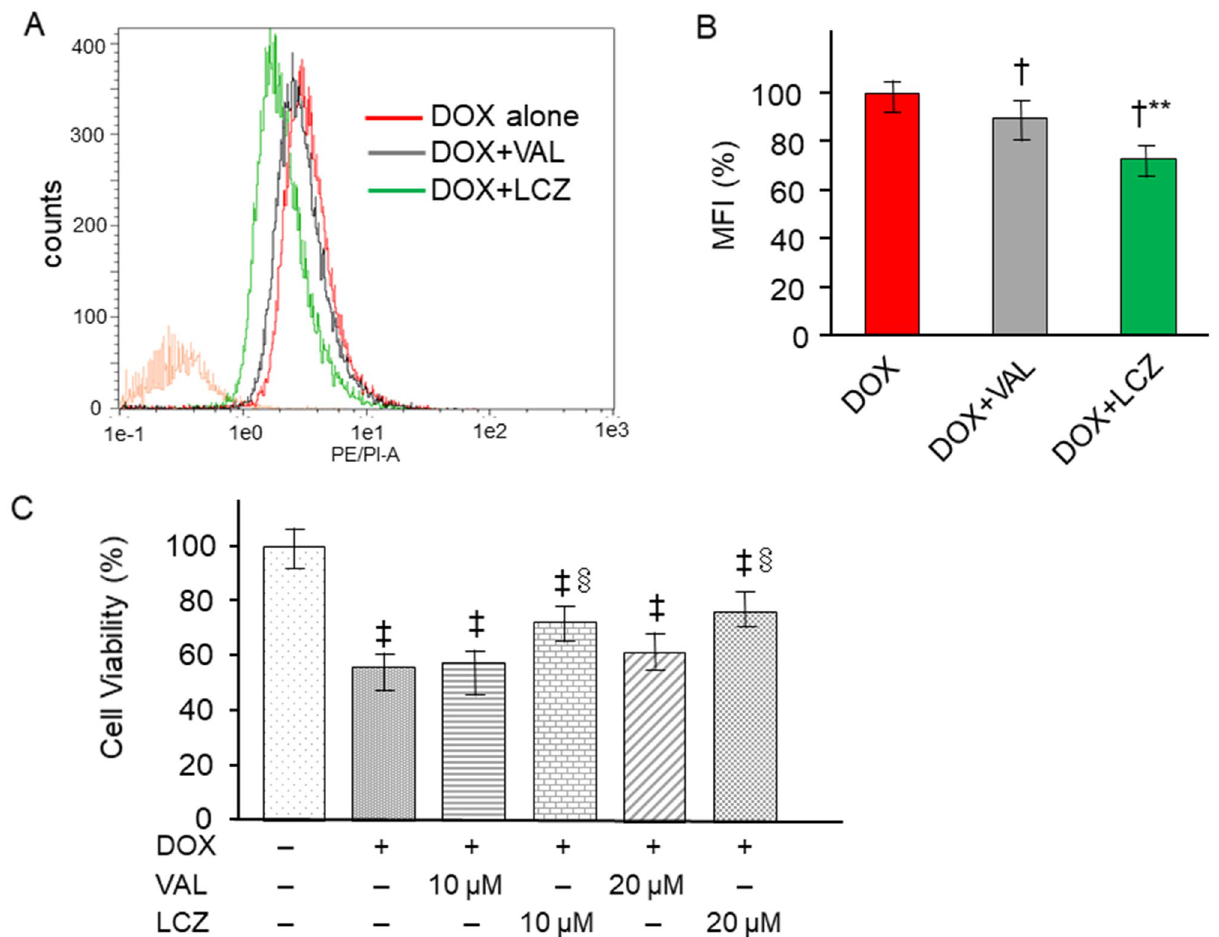
Figure 6. Effect of LCZ696 on doxorubicin-induced mitochondrial oxidative stress and cytotoxicity in H9c2 cells. ( A ) Cells were stained for superoxide using MitoSOX, a fluorescence indicator of mitochondrial superoxide, and were assayed via flow cytometry. Cells were pre-treated with 20 μM VAL and LCZ for 12 h, and then treated with 5 µM of doxorubicin for 6 h. ( B ) The mean fluorescence intensity was measured through flow cytometry in individual cells and plotted. LCZ effectively attenuated DOX-induced superoxide generation. Data are expressed as the mean ± standard error. n = 3 in each group. † p < 0.01 versus DOX and ** p < 0.05 versus DOX + VAL. ( C ) Cell viability was measured with MTS assay and expressed as the percentage of control. DOX markedly decreased cell viability. Pre-treatment with 10 μM and 20 μM LCZ ameliorated cytotoxicity, whereas pre-treatment with VAL did not inhibit DOX-induced cytotoxicity. Each point represents the mean ± standard error. n = 5 in each group. ‡ p < 0.05 versus control and § p < 0.05 versus DOX treatment alone. DOX, doxorubicin; VAL, valsartan; LCZ, LCZ696; MFI, mean fluorescence